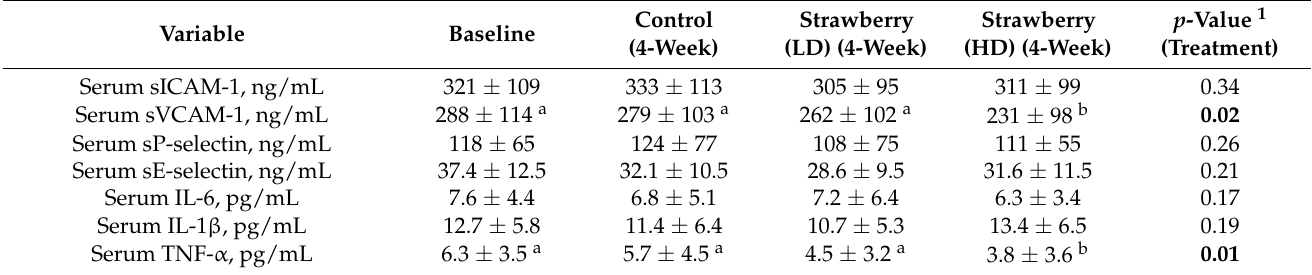
Table 2. Serum biomarkers of endothelial dysfunction and inflammation in adults with the metabolic syndrome following control, low, and high-dose strawberries for a period of four weeks each in a randomized crossover study.